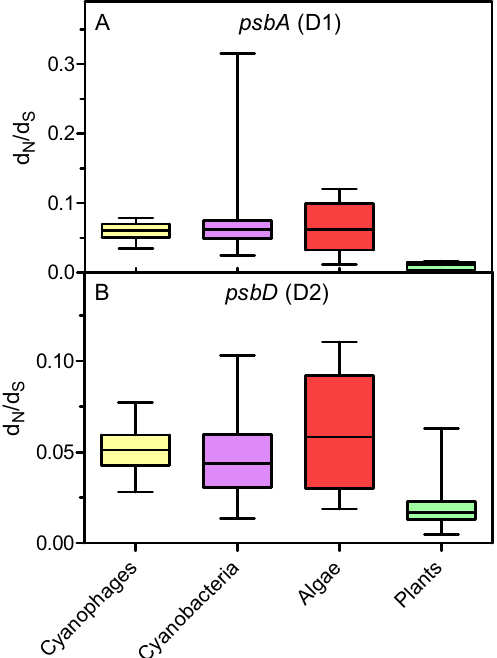
Figure 4. The pattern of evolutionary changes in CDSs for psbA (D1) and psbD (D2). ( A ) d N /d S values of psbA . ( B ) d N /d S values of psbD . Data represent min–max and median values. Values were determined within groups: cyanophages, cyanobacteria, algae and plants. See a detailed list of sequences and species (Supplementary Information Notes S7 and